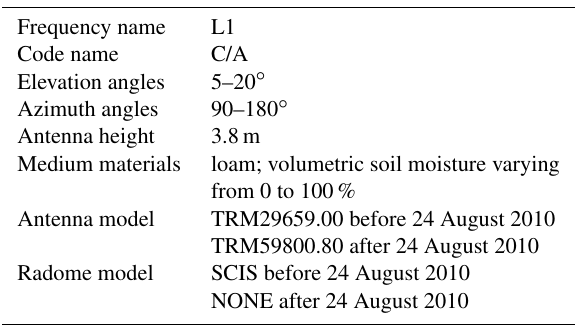
Table 2. Key settings used in MPSImulator. The others are set to the defaults.